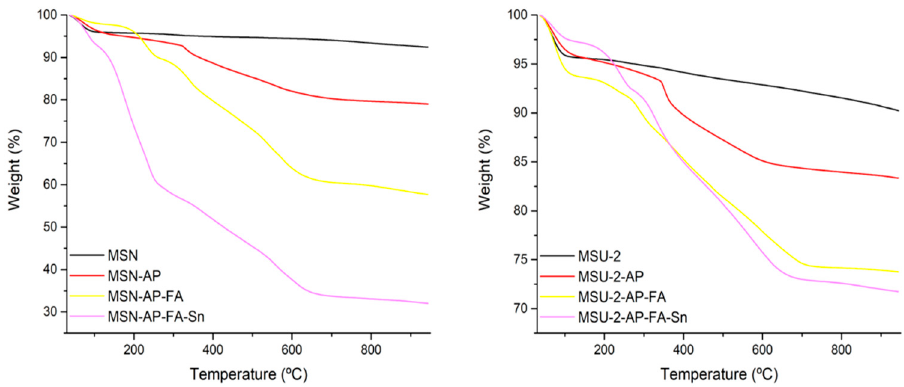
Figure 6. Thermogravimetric studies of MSN-based systems ( left ) and MSU-2-based materials ( right ).